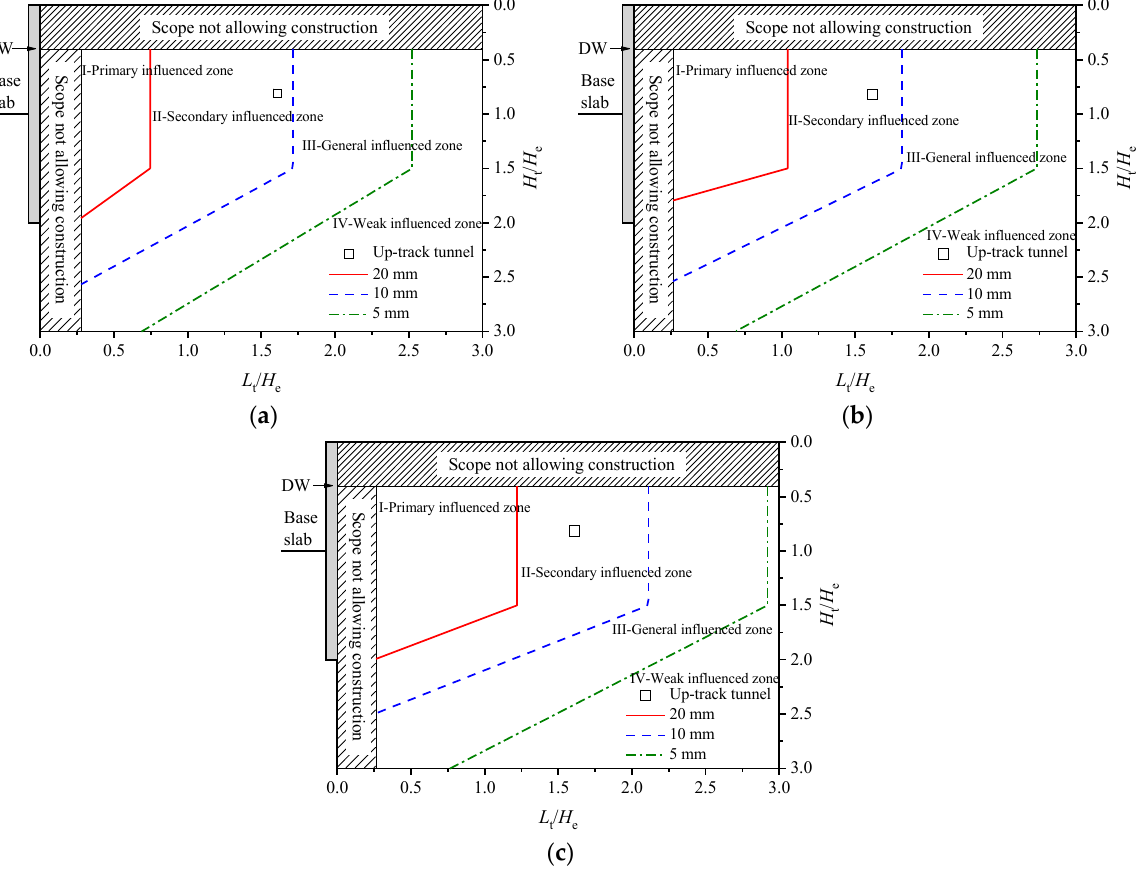
Figure 16. Influenced zones of deep excavation in podium building area: ( a ) H e = 22.3 m, δ hm = 0.18% H e ; ( b ) H e = 22.3 m, δ hm = 0.3% H e ; ( c ) H e = 22.3 m, δ hm = 0.7% H e